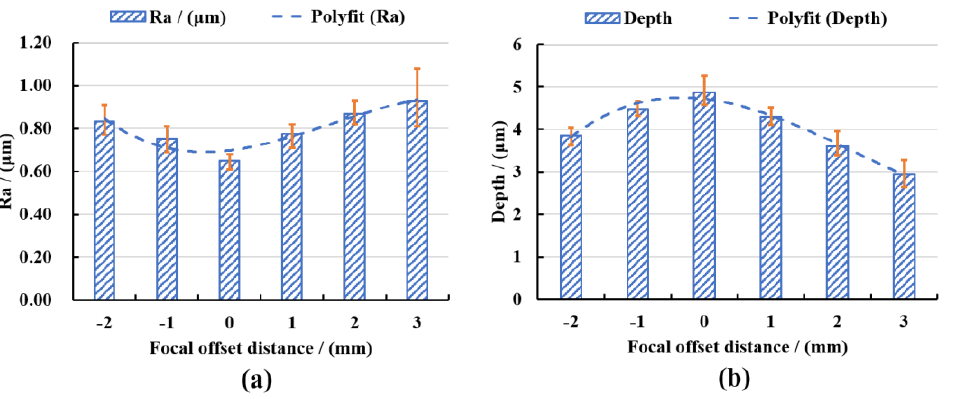
Figure 14. ( a ) The variation of surface roughness with defocus amount and ( b ) the variation of polishing depth with defocus amount.